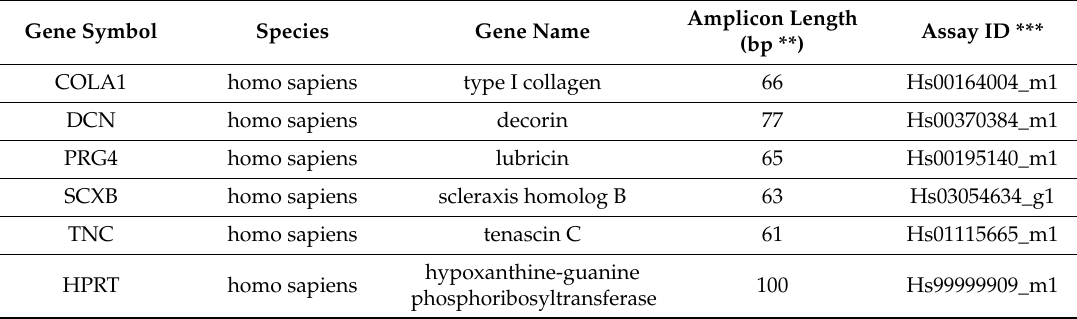
Table 2. The primer sequences used for